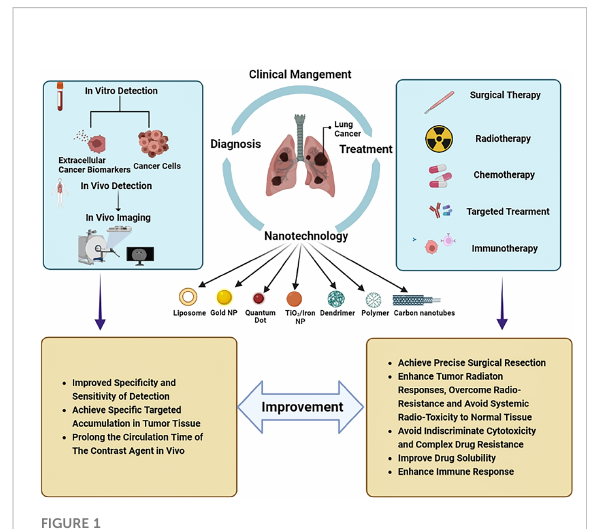
FIGURE 1 Nanotechnology-based clinical management of lung